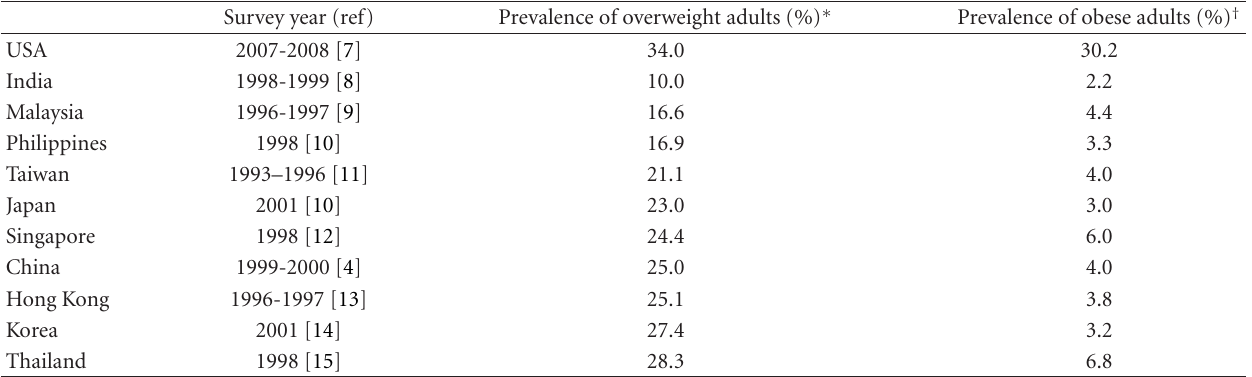
Table 1: Comparison of prevalence of adult obesity in Asian countries versus the